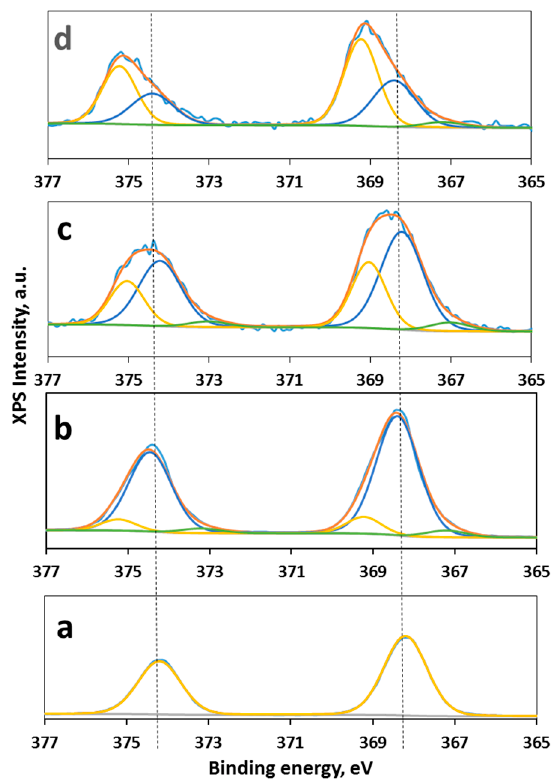
Figure 11. High resolution Ag 3 d X-ray photoelectron spectroscopy (XPS) spectra of ( a ) pure Ag 2 O and Ag doped CeO 2 in different CeO 2 :Ag ratio ( b ) 10:1, ( c ) 20:1, and ( d ) 30:1. Table 3. Binding energies and integrated peak areas of Ag 3 d spin-orbit doublets in Ag 2 O, Ag doped CeO 2 and CeO 2 thin films.